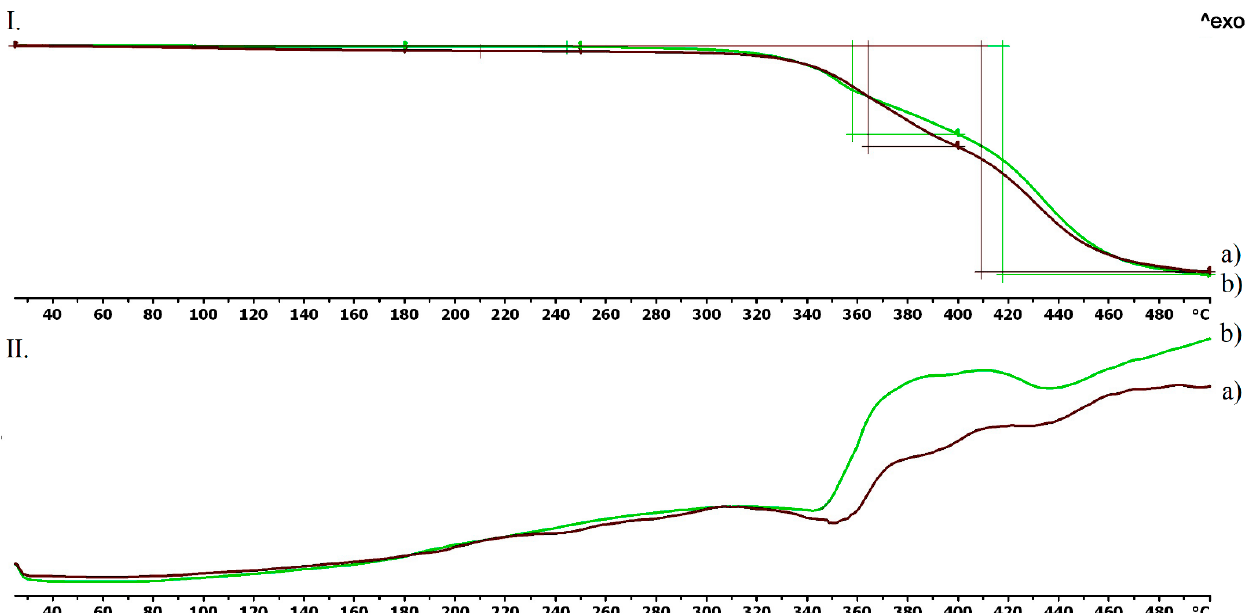
Figure 3. Thermogravimetric ( I ) and heatflow ( II ) analysis of the TPU filament ( a ) and the empty vaginal ring ( b ). Thermal behavior was analyzed between 25 °C and 500 °C.